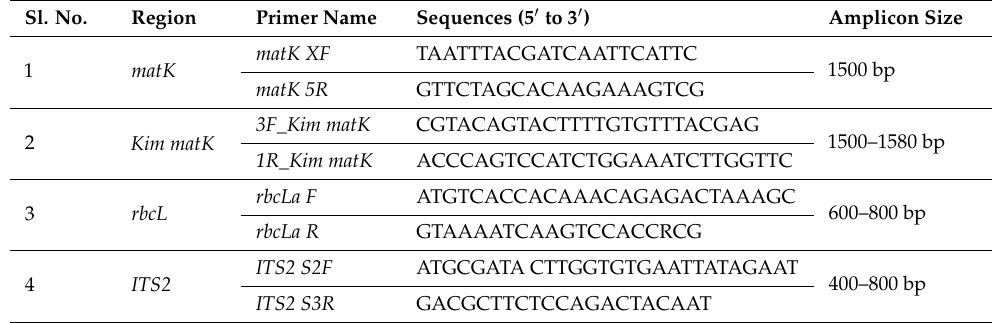
Table 1. List of the barcoding primers used for PCR amplification of Eryngium spp. Sl.